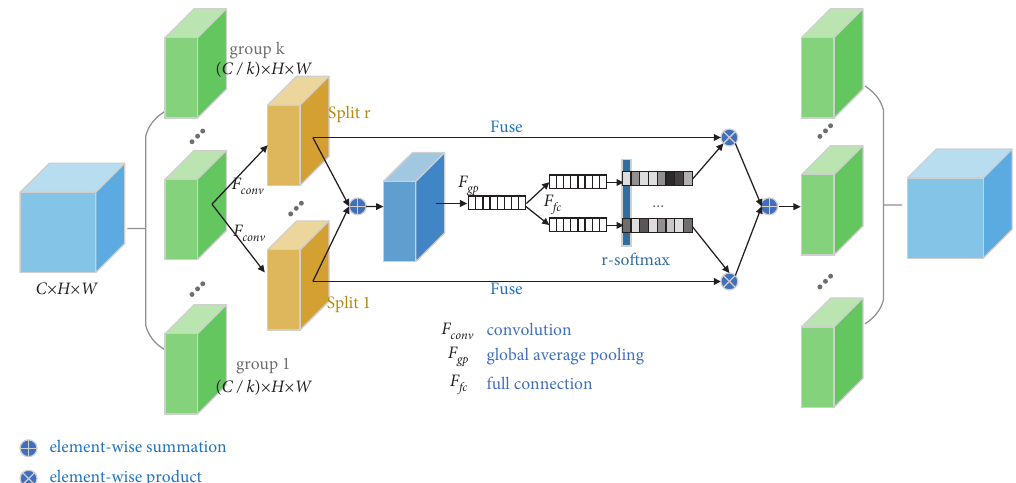
Figure 4: The structure of encoder